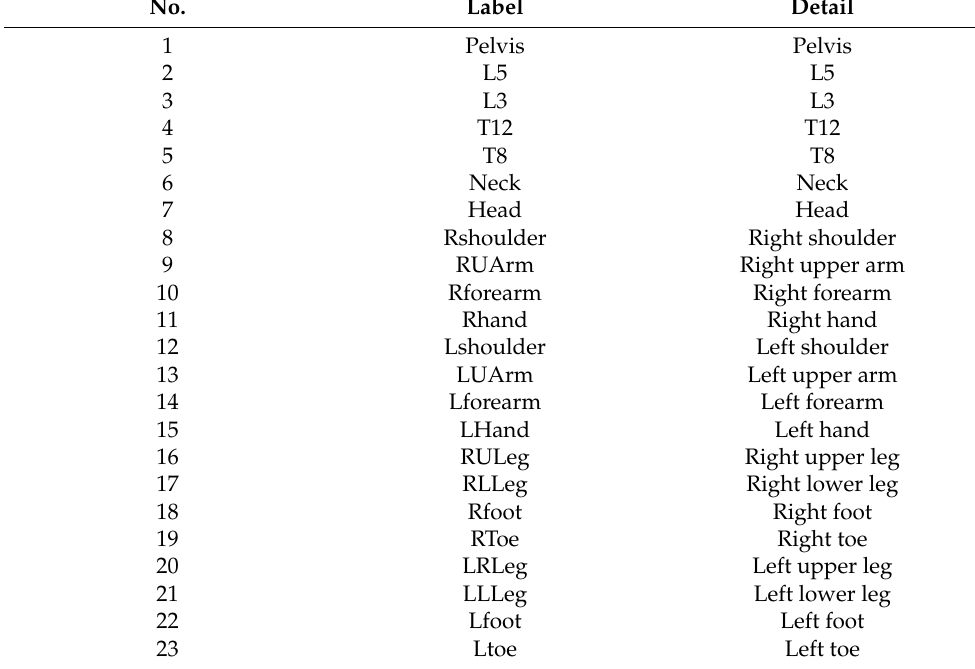
Table 1. The details of collectable joints by Xsens